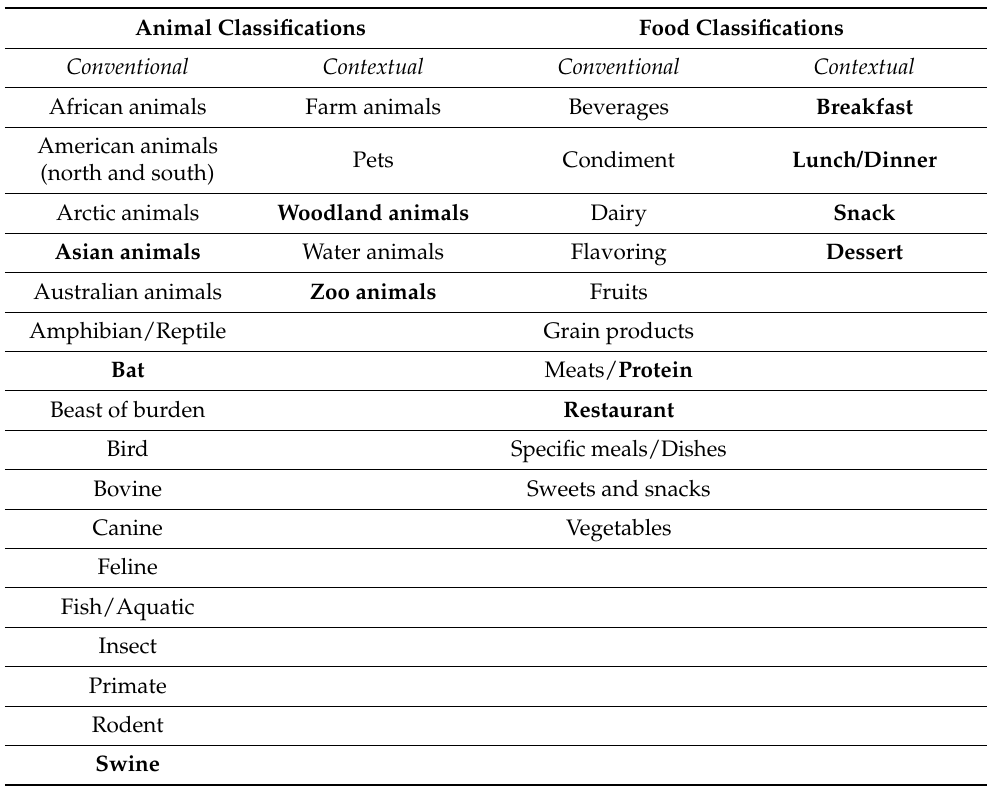
Table 1. Animal and food classifications for conventional and contextual coding schemes adapted from Troyer